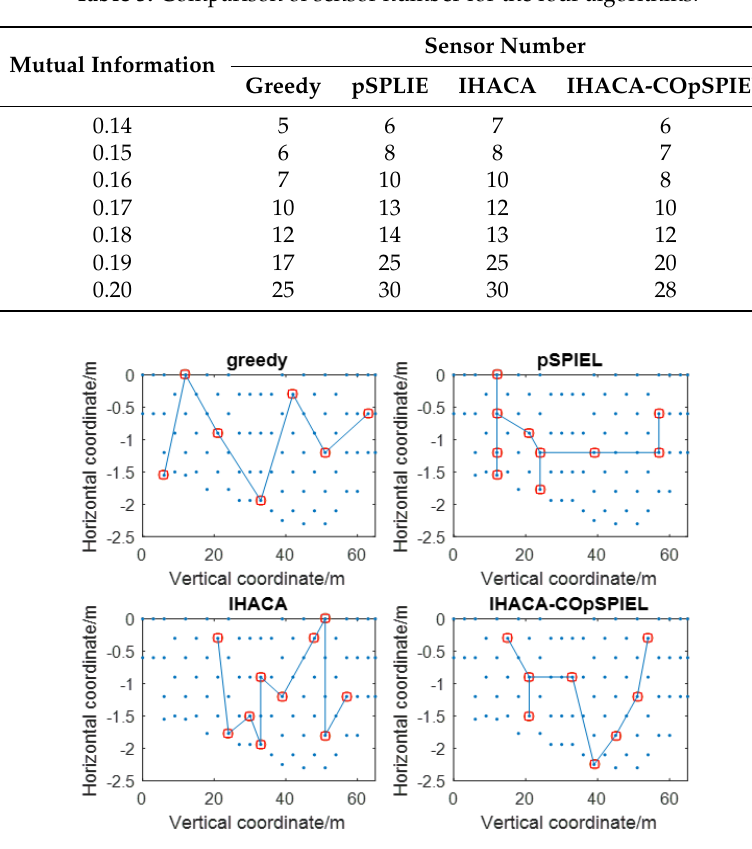
Figure 1. Sensor deployments of the four algorithms.